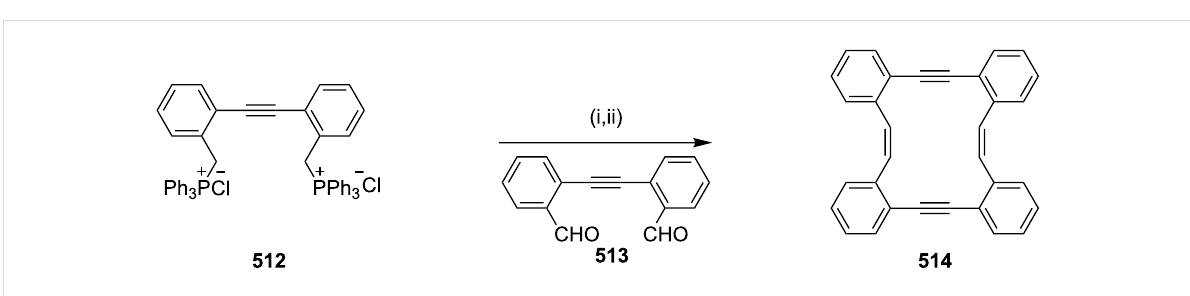
Scheme 95: Cyclophane synthesis via Wittig reaction. Reagents and conditions: (i) LiOEt (2.1 equiv), THF, − 78 °C to 0 °C, 0.5 h; (ii) 513 (1.1 equiv), THF, − 78 °C to 0 °C, rt, 4